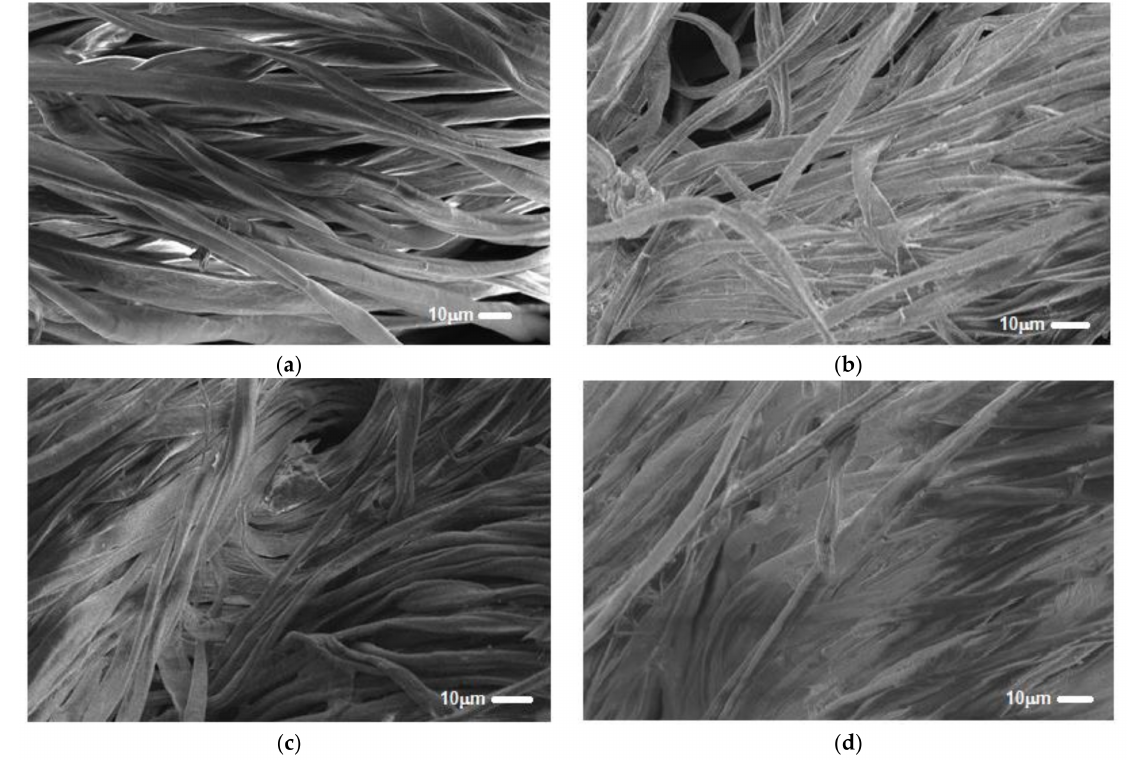
Figure 6. SEM images of untreated cellulosic sample ( a ) and PEM functionalized bio-sorbent with different layers; 2 layers ( b ), 3 layers ( c ) and 5 layers ( d ).